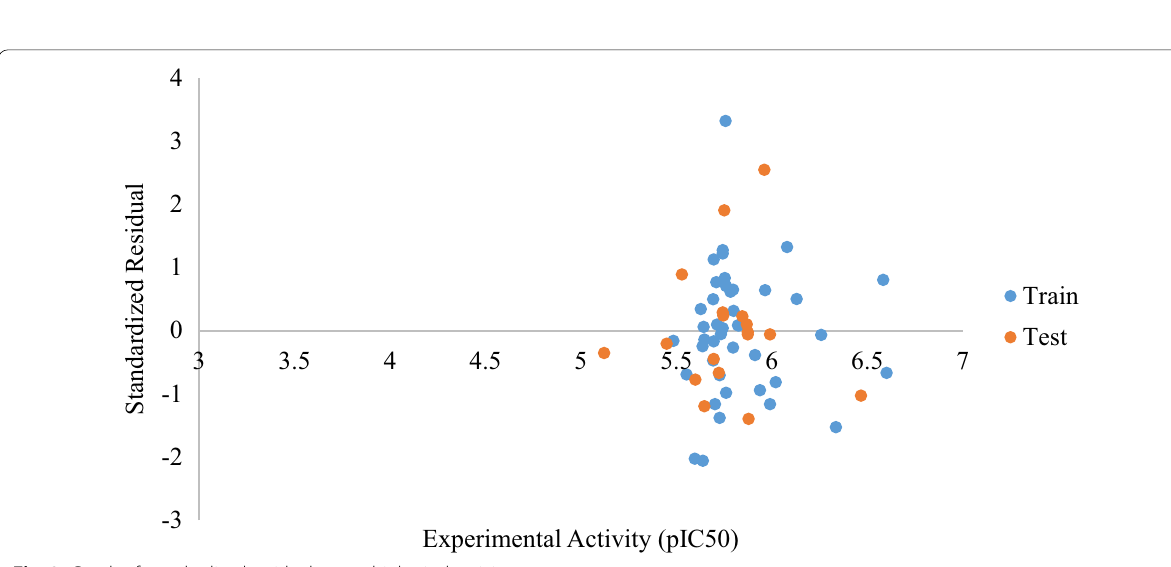
Fig. 3 Graph of standardized residual versus biological